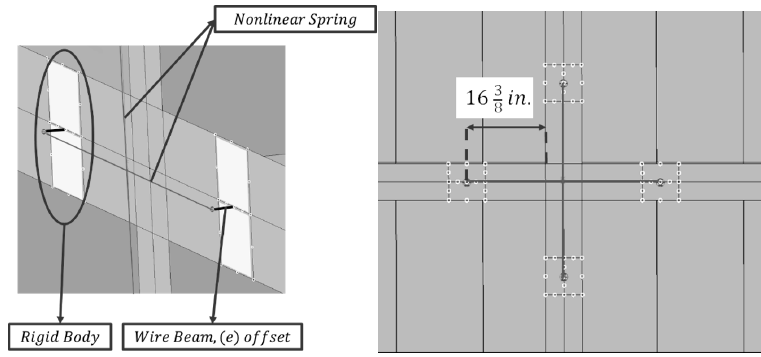
Figure 11. Retrofit application on section F13 in the FEA model.